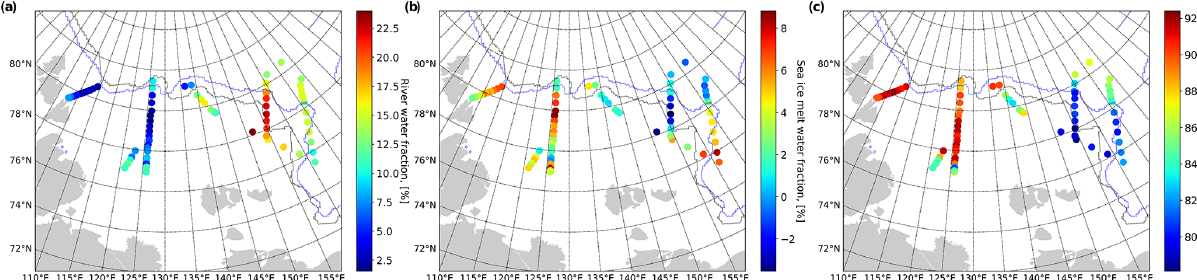
Figure 14. Fractions of river water (a) , sea ice melt water (b) , and marine water (c) , calculated using δ -O 18 measurements and the Bauch and Cherniavskaia (2018) three-component model of freshwater balance. A thin black line shows the position of sea ice edge on 31 August 2018, when the northern stations of the meridional (5) transect along 126 ◦ E were done in the MIZ, and the blue line shows the sea ice edge on 16 September 2020, when the ARKTIKA-2018 expedition was working in the MIZ of the East-Siberian Sea. Please note that the color bar scale is different for each water